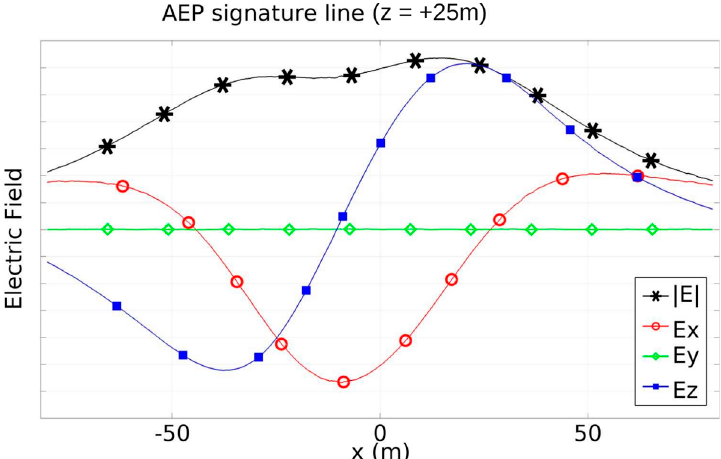
Figure 12. Numerically simulated AEP signature line for a submarine model. The fields were sampled along the sensor line in the x ‐ direction at a constant height of z u = +25 m below the waterline (40 m above the keel of the submarine). The ordinate scale is the same as in Figure 11.